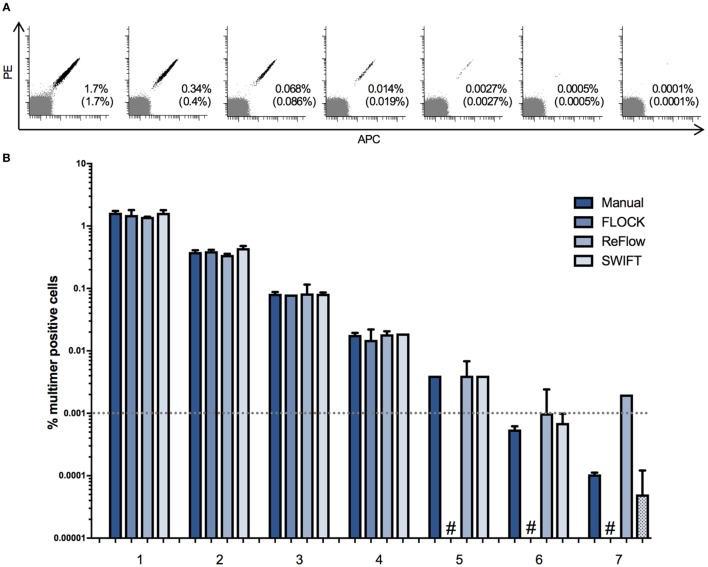
Limit of detection for different automated approaches. A donor carrying ~1.7% CD8+ T cells binding to HLA-B*0702 cytomegalovirus (TRP) was spiked into an HLA-B0702 negative donor in fivefold dilutions in order to assess the limit of detection of the four analysis approaches. The experiment was run in duplicates. (A) Dot plots of the spiked samples showing the theoretical frequency of multimer + cells of the total lymphocyte population and the actual detected frequency (in brackets) by manual gating. Multimer + cells are double positive for PE and APC. PE: phycoerythrin; APC: allophycocyanin. (B) The mean percentage of multimer positive cells out of single, live lymphocytes. Numbers represent the seven different samples. Dotted bars: the software detected zero specific cells in one of the two duplicates. #: the software was unable to detect the specific populations in both duplicates. Dashed line: a typical detection threshold for positive response in a major histocompatibility complex multimer staining.